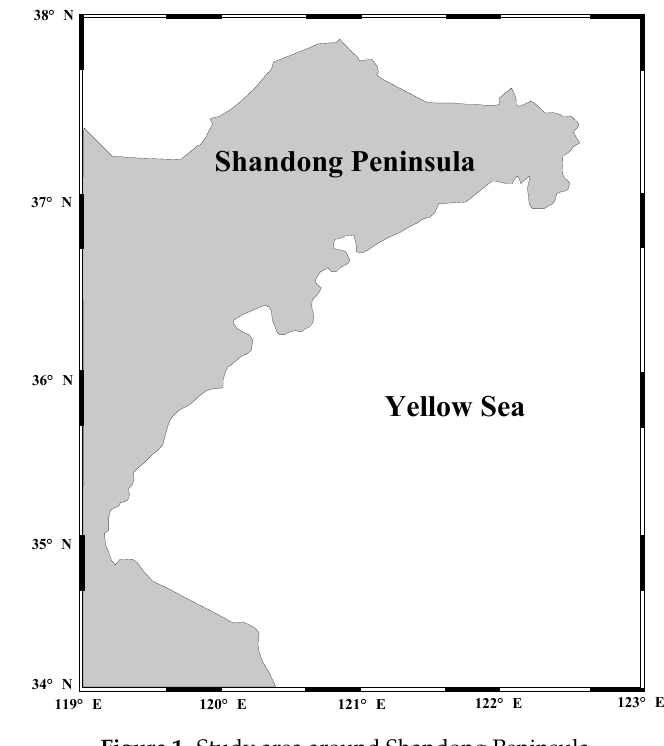
Figure 1. Study area around Shandong Peninsula.